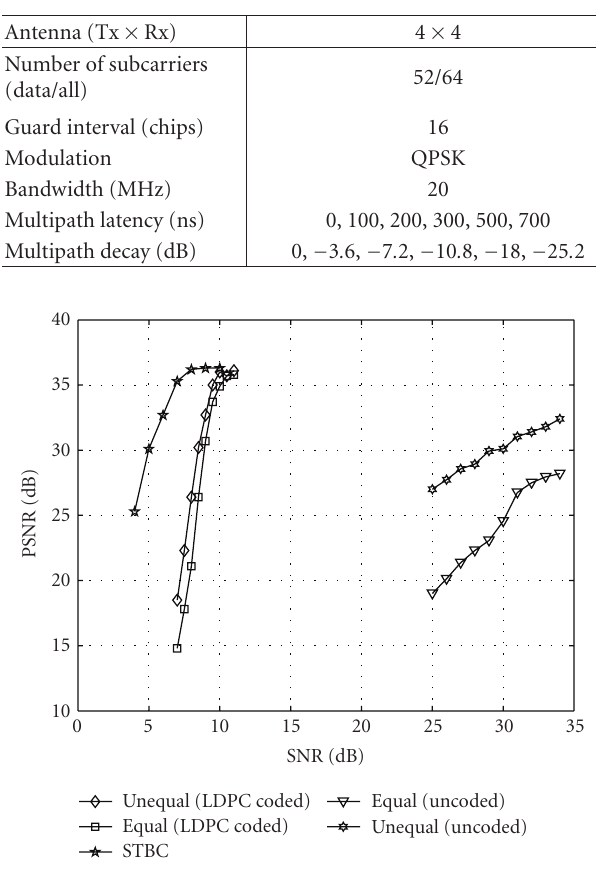
Table 1: Simulation parameters.